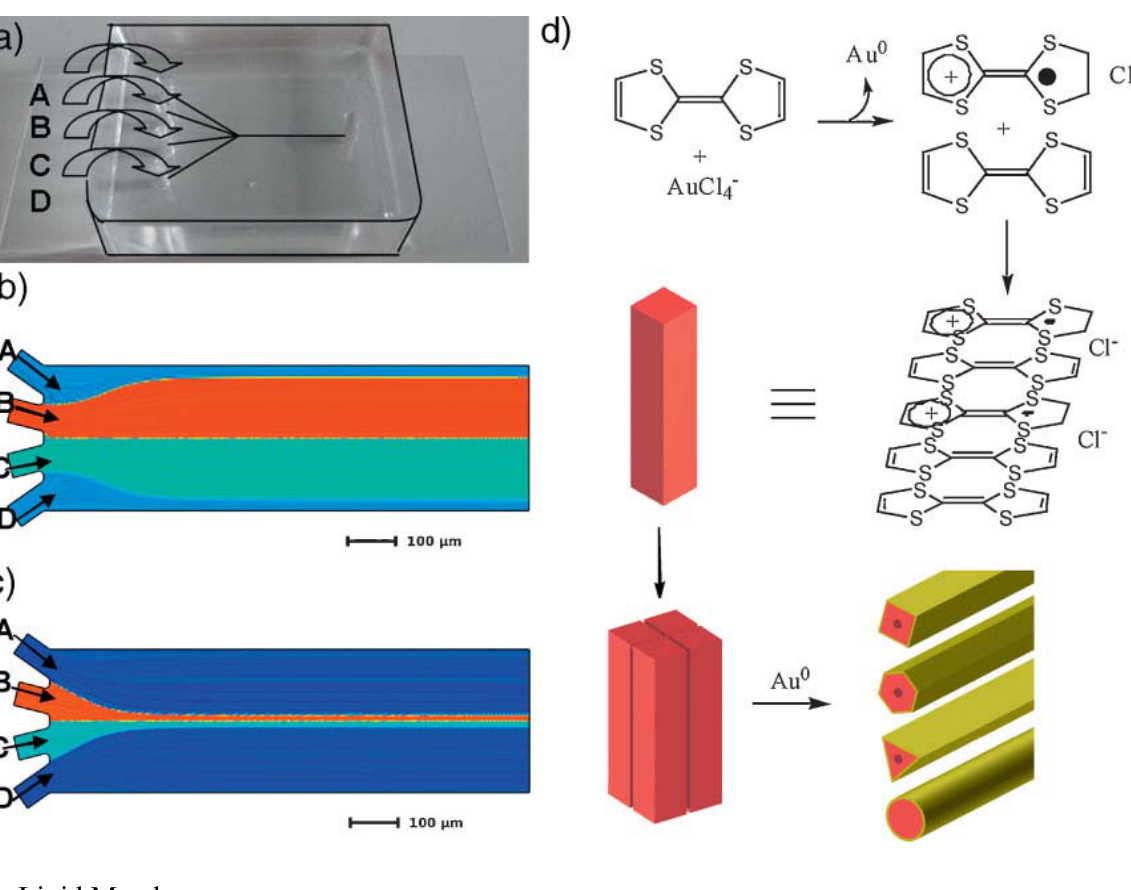
Figure 9. ( a ) Microscopy image of the microreactor used for the synthesis. Each input channel is indicated with arrows. A and D are the sheath flows, B and C the reactant flows. ( b , c ) Finite element analysis simulation illustrating the microfluidic chip design and the concentration profiles of the reactants along the microchannel at a flow-rate ratio of ( b ) 0.1 and ( c ) 10 and a total flow rate of 1100 μ L/min (top view, red stream: TTF, light-blue stream: Au, dark-blue streams: acetonitrile sheath flows). ( d ) Scheme illustrating the supramolecular organization of the composites (Reproduced with permission from [79]. Copyright 2010 Wiley-VCH Verlag GmbH & Co.